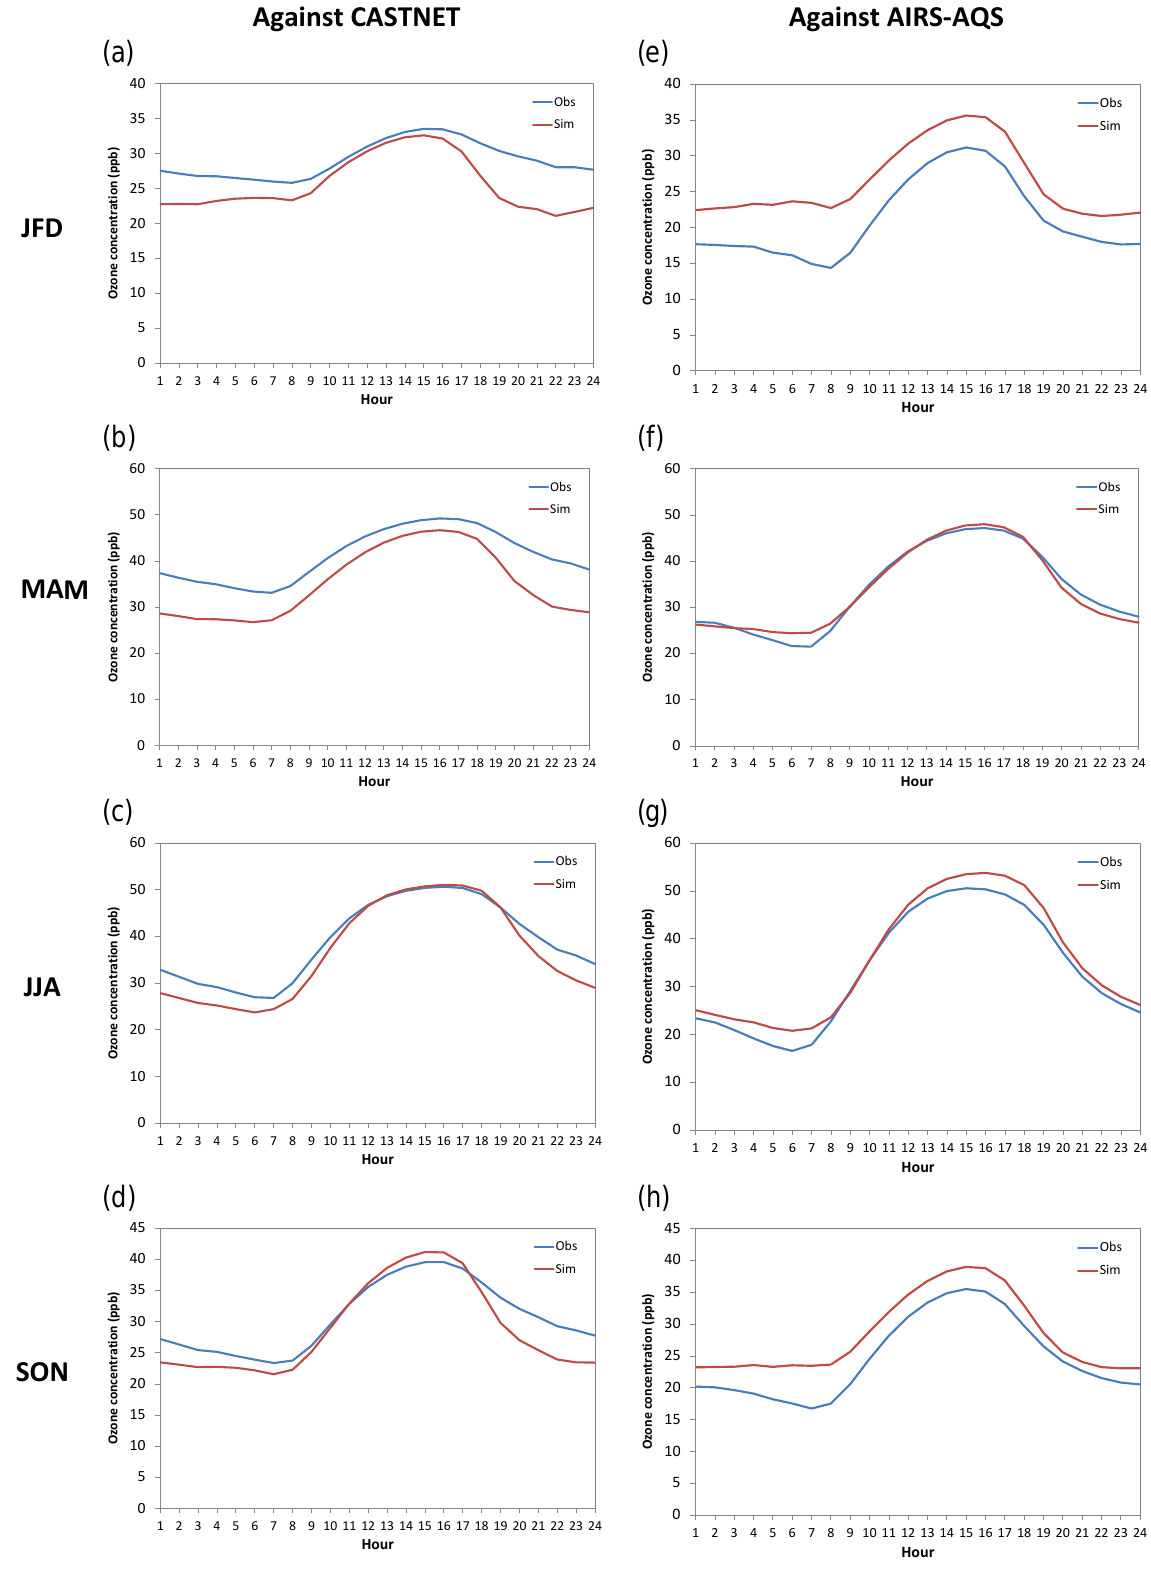
Figure 6. Diurnal variation of observed vs. simulated hourly O 3 concentrations against CASTNET (left column from a to d ) and AIRS-AQS (right column from e to h ) for all climatological seasons. The x axes refer to hours in local standard